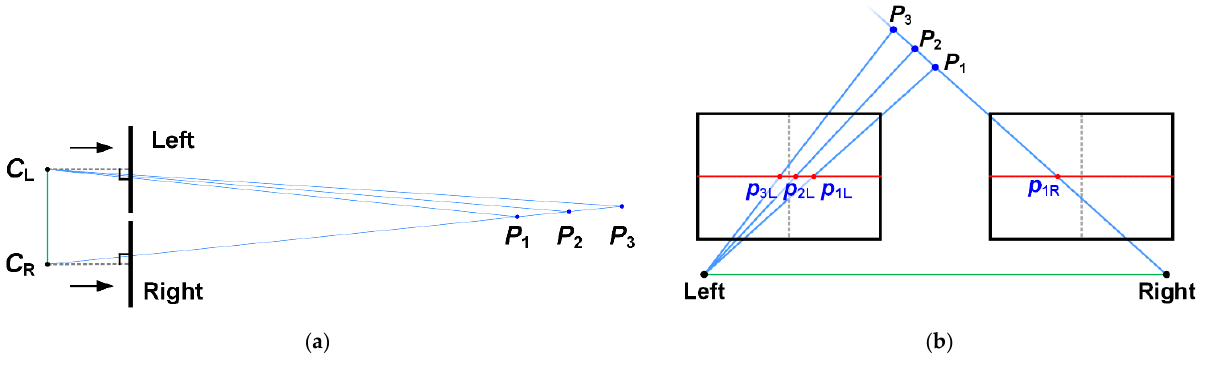
Figure 17. ( a ) Top view and ( b ) front view of stereo vision with Epipolar phenomenon.